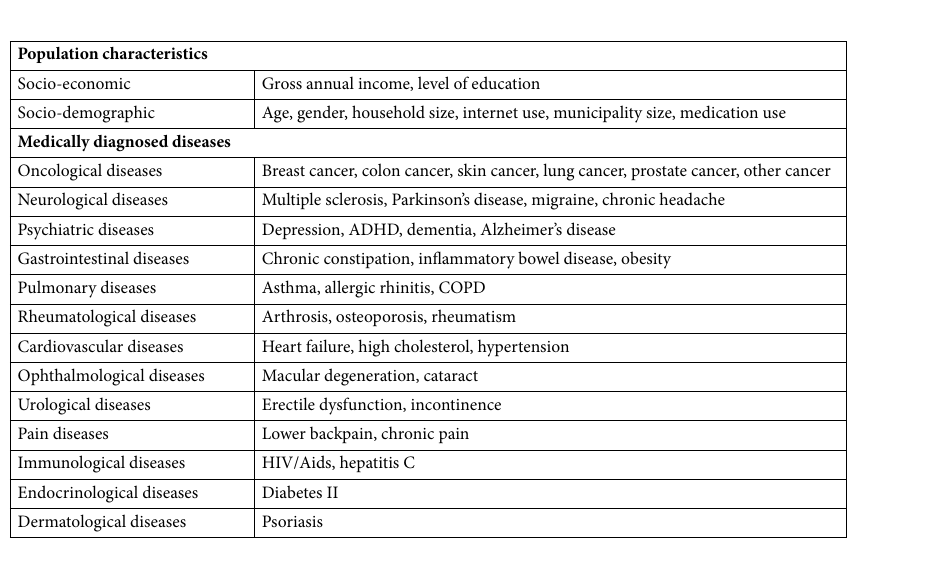
Table 2. Population characteristics and medically diagnosed